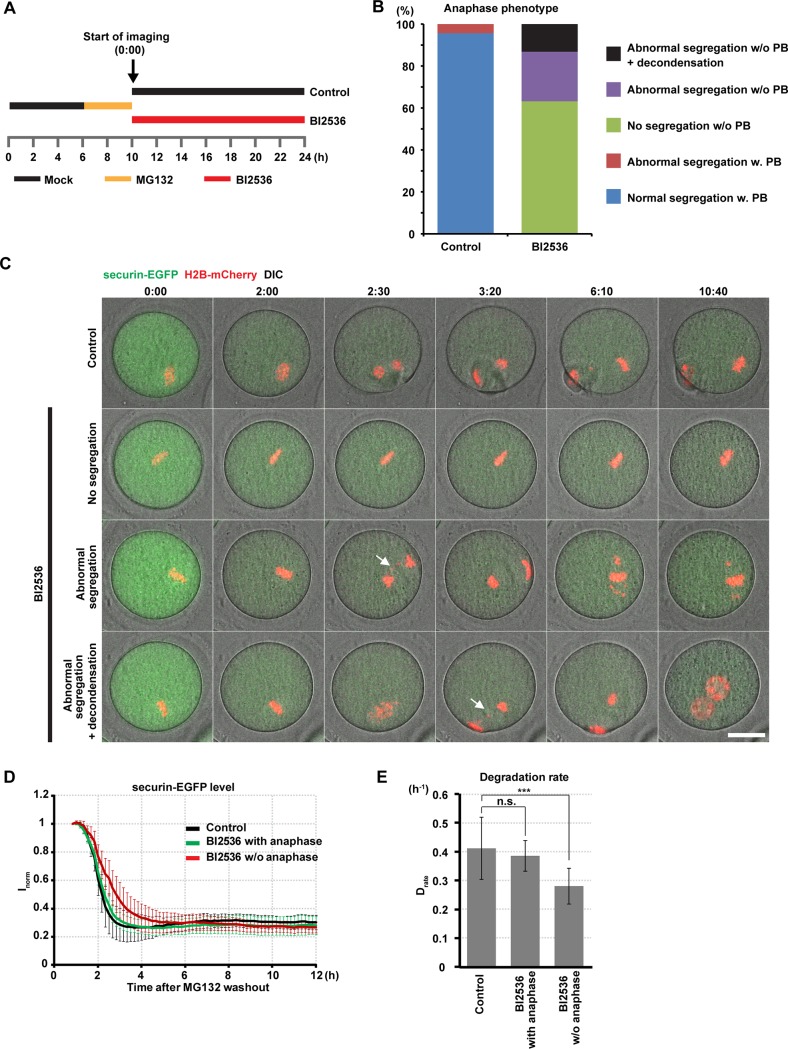
PLK1 is required for chromosome segregation, first polar body extrusion, and maintenance of the condensed state of chromosomes.(A) Experimental scheme. Oocytes were cultured for 6 hours in
control medium, and then MG132 was added. The oocytes were incubated for 4 hours to arrest oocytes at the late metaphase I. After release from MG132, 100 nM BI2536 was added and oocytes were imaged. (B) Anaphase phenotypes after MG132 release in control and BI2536-treated oocytes. PB = the first polar body. (C) Imaging of securin-EGFP (green) and H2B-mCherry (red) after DMSO (control, top) or 100 nM BI2536 (lower panels) was added at the time of the MG132 washout. Each phenotype from Fig. 6B is shown on a representative image sequence. Arrows indicate lagging chromosomes. Note that none of the BI2536-treated oocytes undergoing abnormal chromosome segregation extruded the first polar body. Time after MG132 washout (h:mm). Scale bar = 30 μm. Also see S7 Movie. (D) Quantification of securin-EGFP destruction. Values were normalized to 1 when the imaging was started. Time relative to MG132 washout (h). The ‘BI2536 with anaphase’ curve represents BI2536-treated oocytes that underwent abnormal chromosome segregation either with or without DNA decondensation (3rd and 4th rows in Fig. 7C). The ‘BI2536 w/o anaphase’ curve represents BI2536-treated oocytes that did not undergo chromosome segregation (2nd row in Fig. 7C). Average and s.d. are shown (n = 23, 40). (E) Degradation rate of securin-EGFP calculated from (D). Average and s.d. are shown. ***p < 0.001.